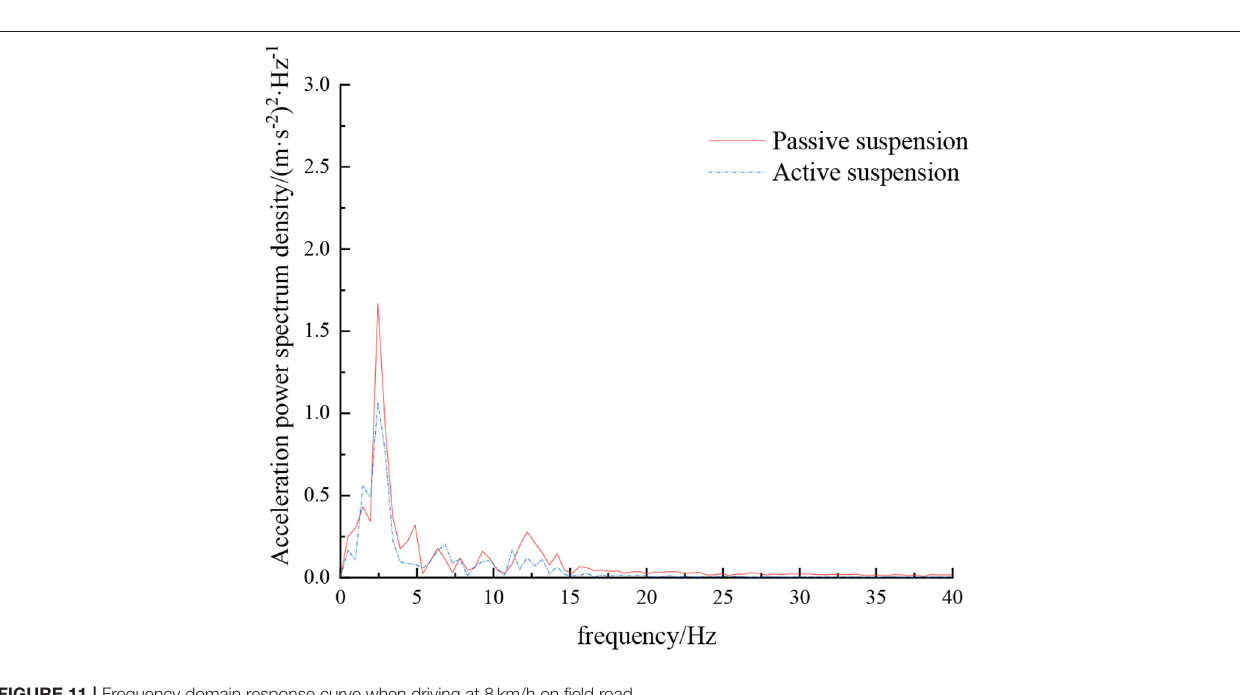
FIGURE 11 | Frequency domain response curve when driving at 8km/h on field